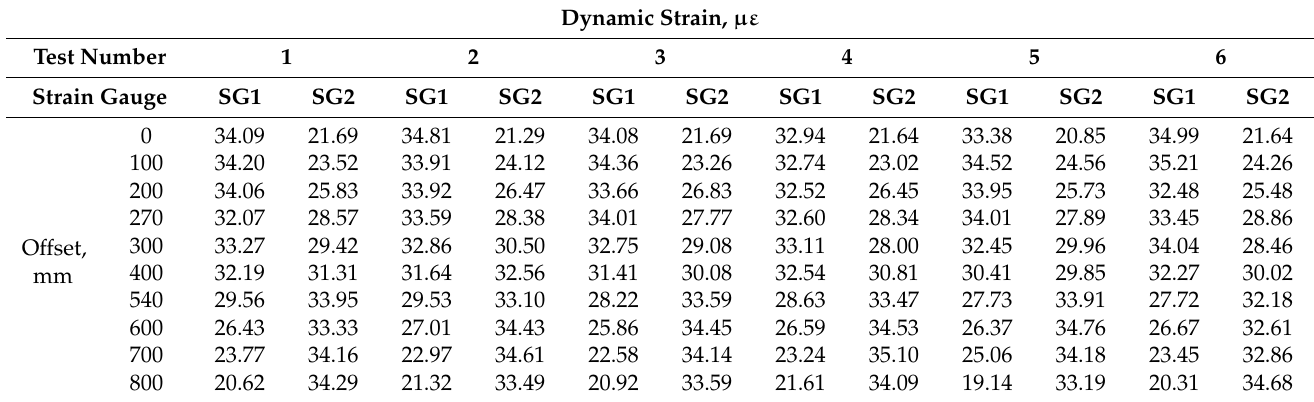
Table 1. Dynamic strains with manually recorded offsets for offset verification.